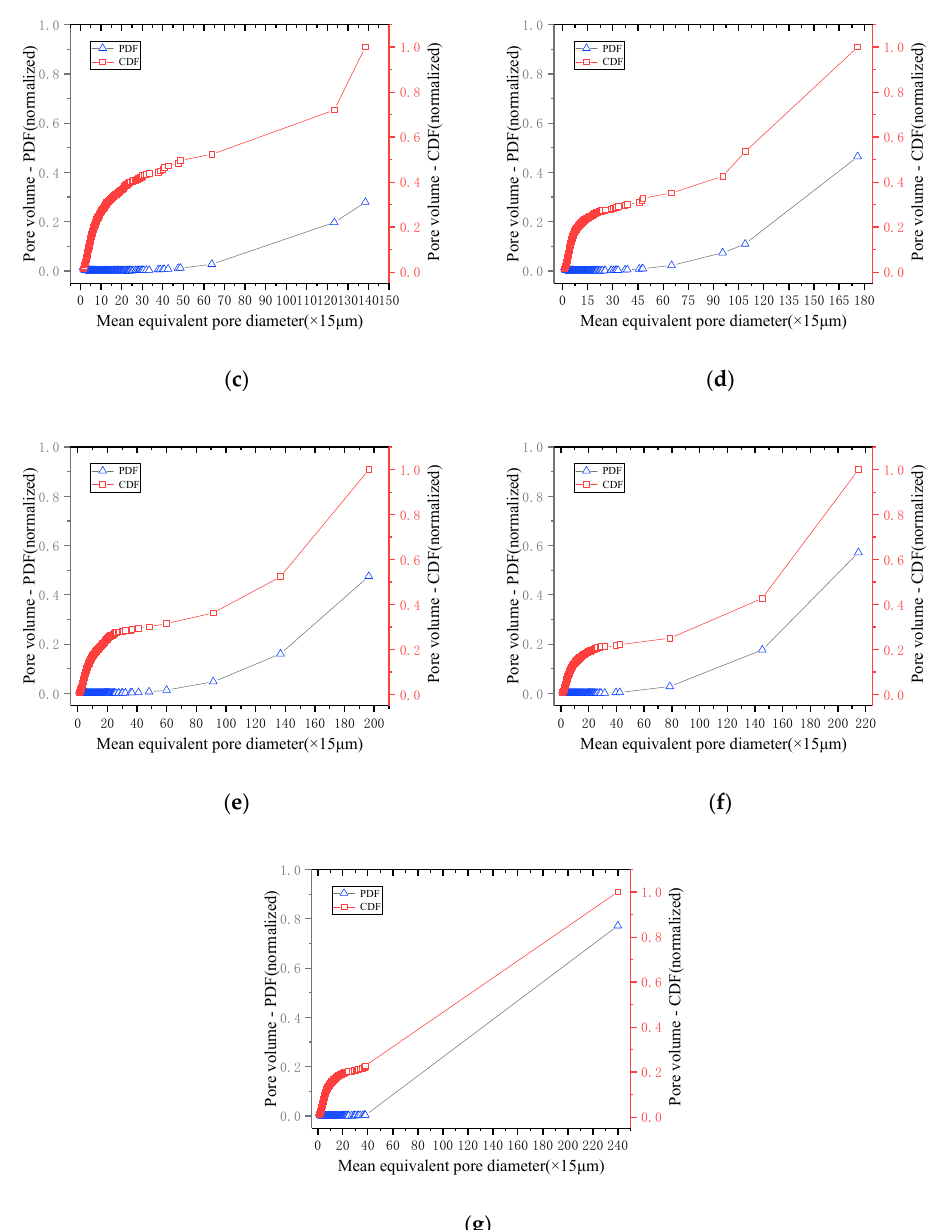
Figure 6. Pore volume distribution at different steam pyrolysis temperatures (both probability density function (PDF) and cumulative distribution function (CDF)): ( a ) 25 °C; ( b ) 314 °C; ( c ) 382 °C; ( d ) 452 °C; ( e ) 511 °C; ( f ) 534 °C; ( g ) 555 °C.